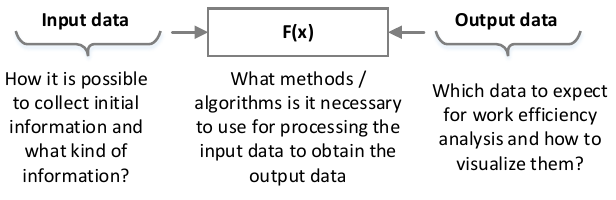
Fig. 1. Definition of the research question of this paper